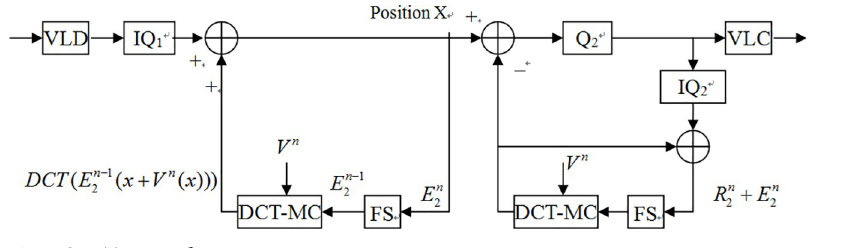
Fig 5. CDDT transcoder.